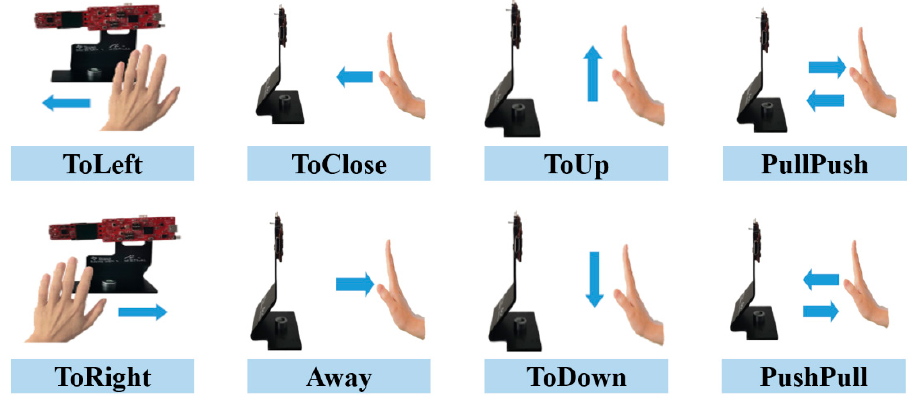
Figure 4. The types of hand gestures.